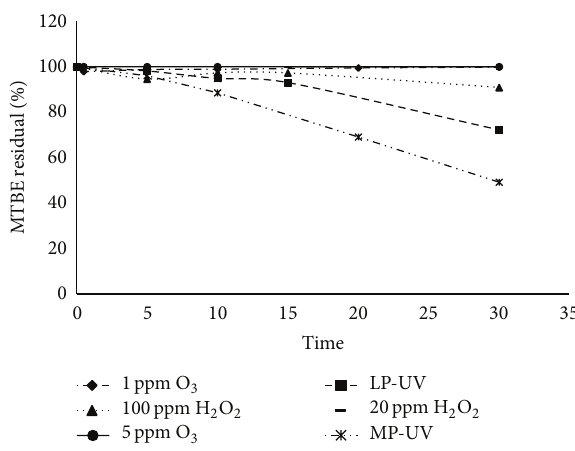
Figure 2: Removal of MTBE using H 2 O 2 , O 3 , and UV